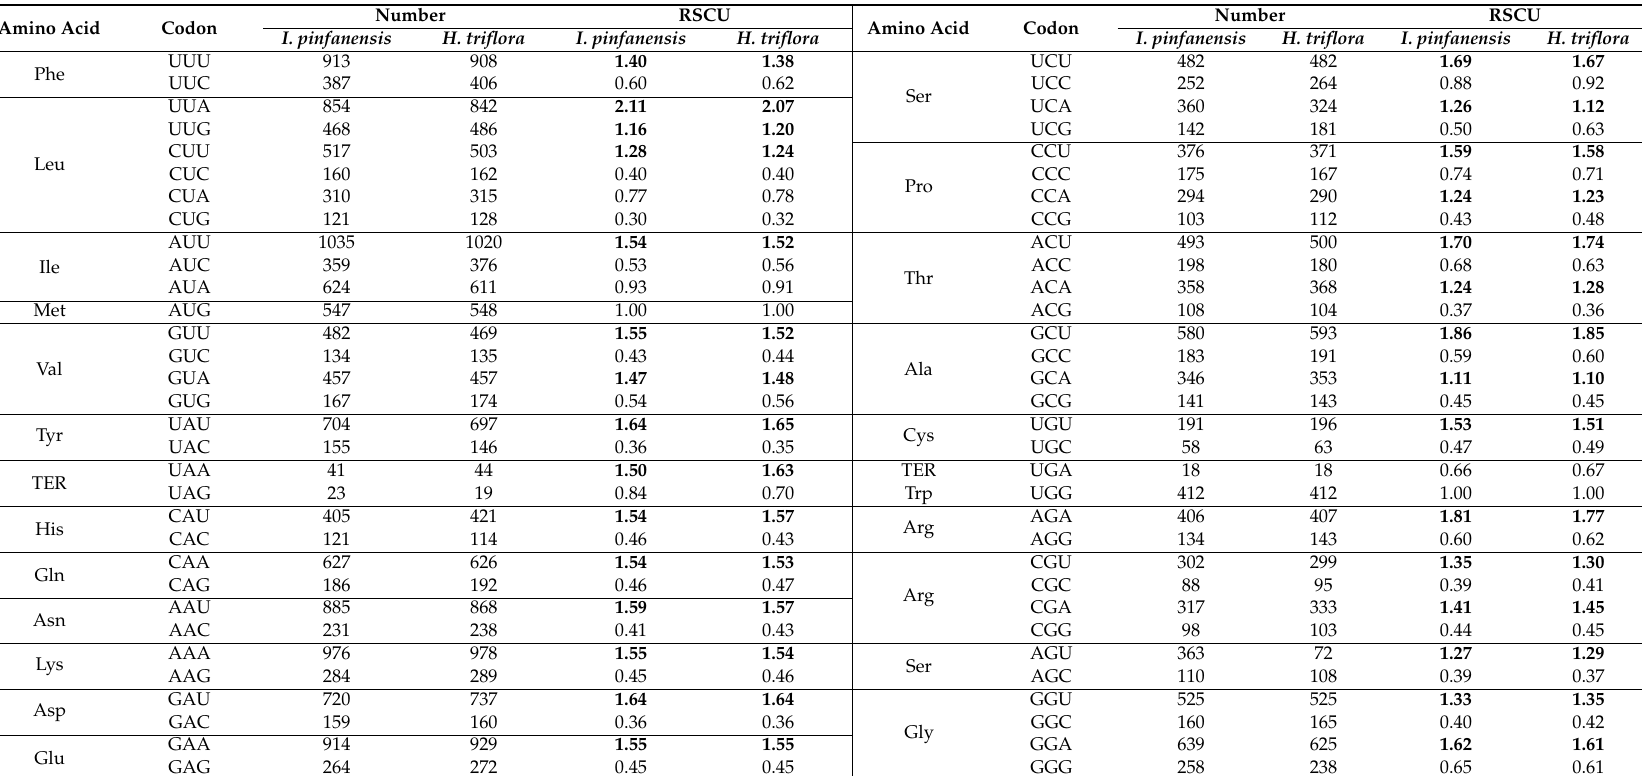
Table 3. Codon usage in Impatiens pinfanensis and Hydrocera triflora chloroplast